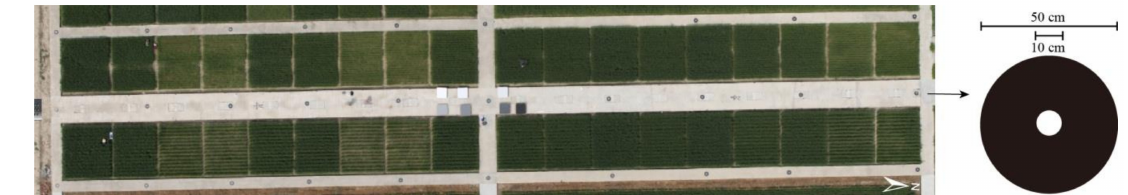
Figure 4. The distribution and the size of the ground control points